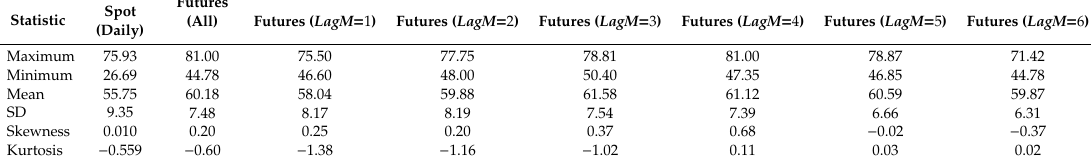
Table 2. Testing period prices ( € /